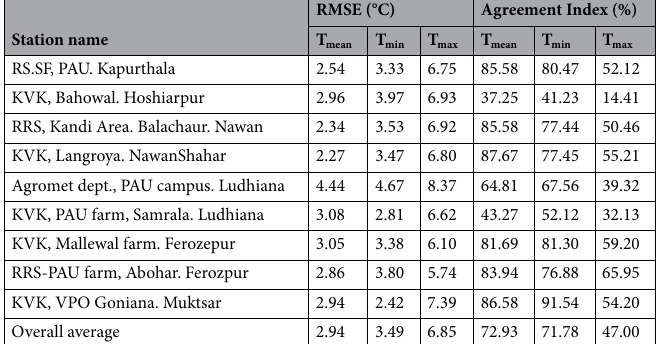
Table 2. Error statistics of daily mean, minimum and maximum temperatures simulated by the WRF model in comparison with data recorded at nine ISRO meteorological stations.